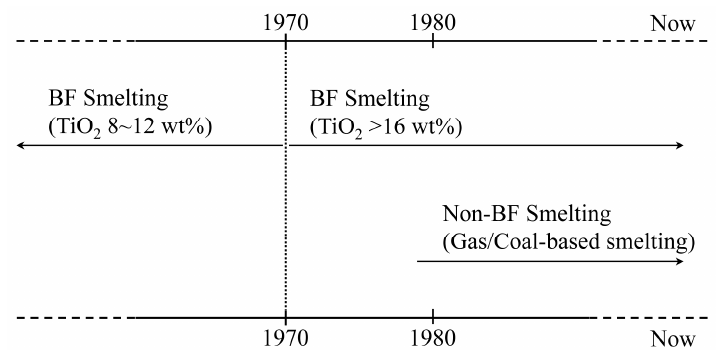
Figure 1. Timeline of the smelting process and development of vanadium titanomagnetite (VTM) in China.